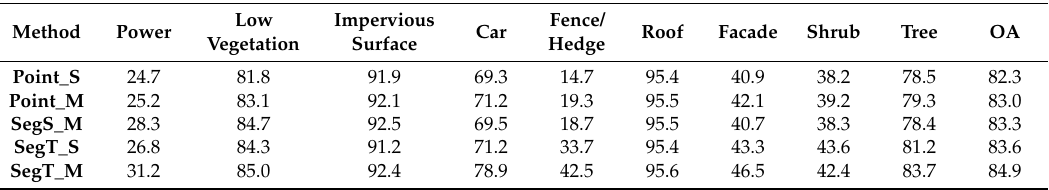
Table 3. Per-class accuracy and the overall accuracy of each strategy.